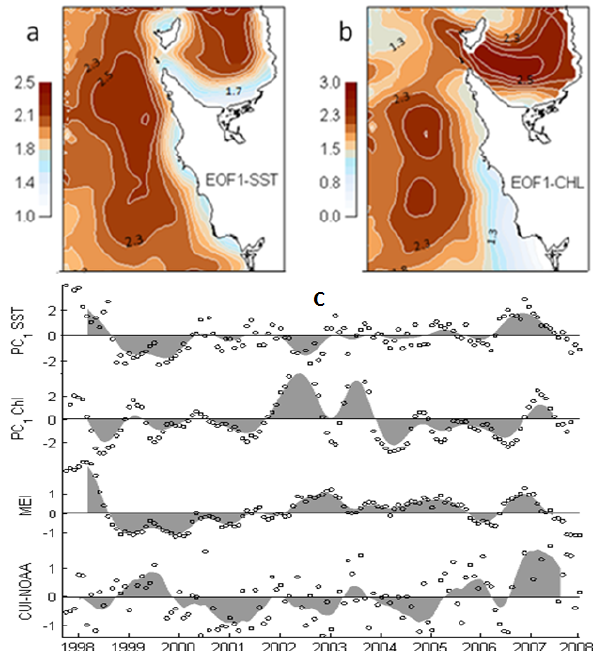
Figure 3. Spatial patterns for mode 1 of the individual EOF analyses. (a) SST, (b) Fig. 3. Spatial patterns for mode 1 of the individual EOF analyses. (a) SST, (b) chlorophyll a . This mode accounts for 78 and 45% of Chlorophyll a. This mode accounts for 78% and 45% of the total variance for SST and the total variance for SST and chlorophyll a (with the sign reversed), Chlorophyll a (with the sign reversed), respectively. (c) Time-series data indicate the respectively. (c) Time-series data indicate the temporal evolution of temporal evolution of the EOF1 alongside the MEI and monthly CUI anomalies, the EOF1 alongside the MEI and monthly CUI anomalies (dots), all smoothed by a five-term running mean (shaded area). observed data (dots) and smoothed by a five-term running mean (shaded area).